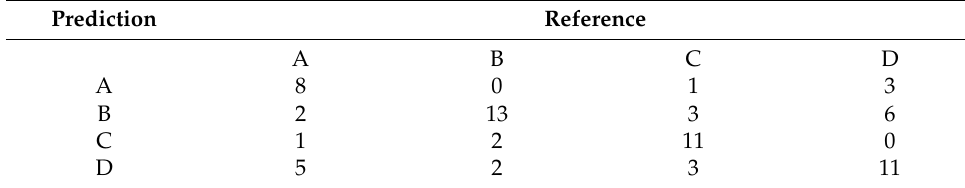
Table 5. Confusion matrix for LDA with the PCA selected wave numbers.